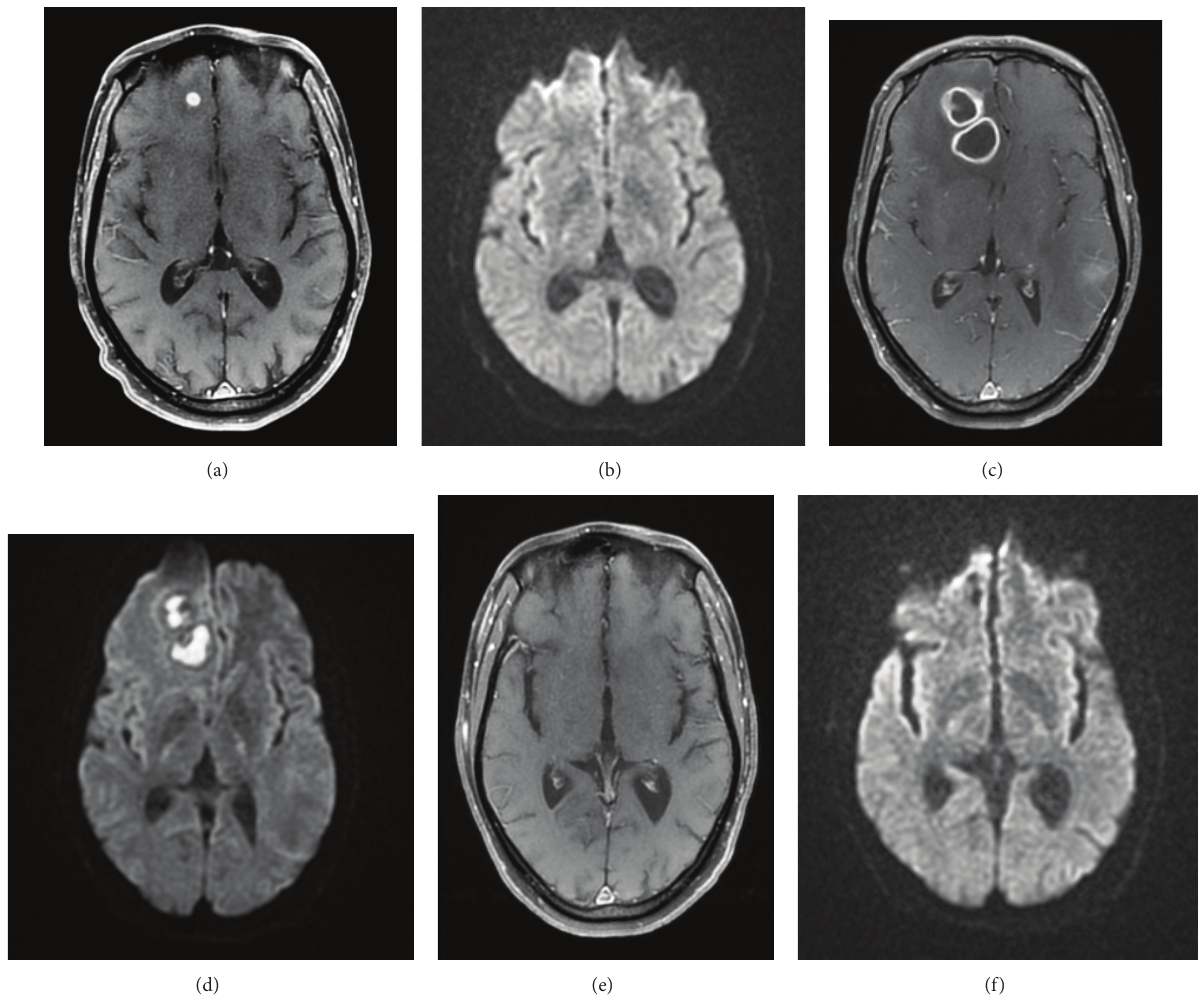
Figure 1: Single small nodular enhancing lesion with discrete central hyposignal (a) not seen on DWI (b). Two ring enhancing lesions (c), with partial restricted diffusion (d). No lesions seen on T1 WI post gad (e) and DWI